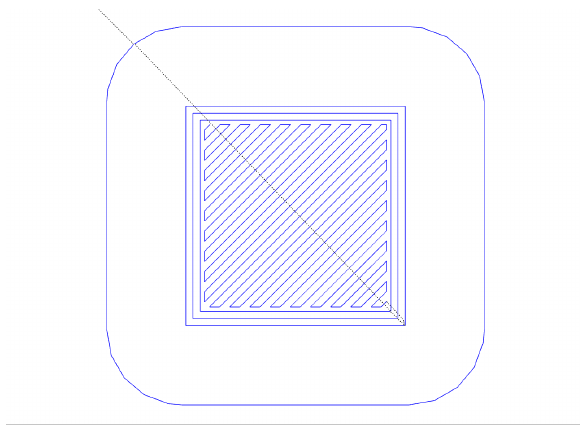
Figure 4. G-code visualization of the first layer of a 20 × 20 × 20 mm cube.